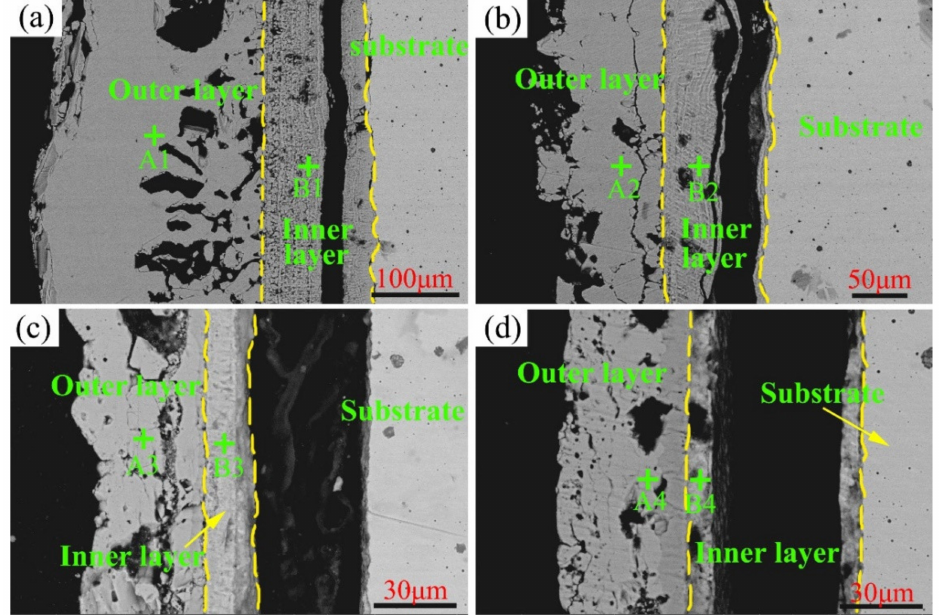
Figure 11. Cross-section morphology of Ni–xCr–Mo laser-cladding coatings observed under back- scattered mode after the sulfur corrosion test at 600 ◦ C for 168 h: ( a ) C1, ( b ) C2, ( c ) C3, and ( d ) C4. Table 6. EDS results (at.%) of typical points displayed in Figure 11. Samples